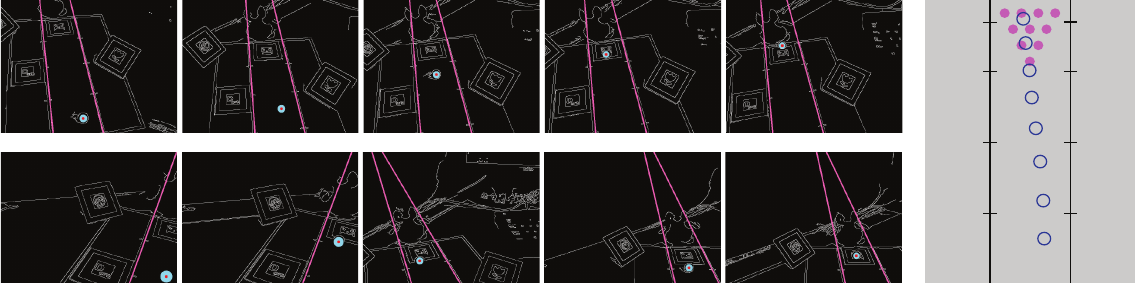
Figure 18: Detected lane and ball and trajectory of